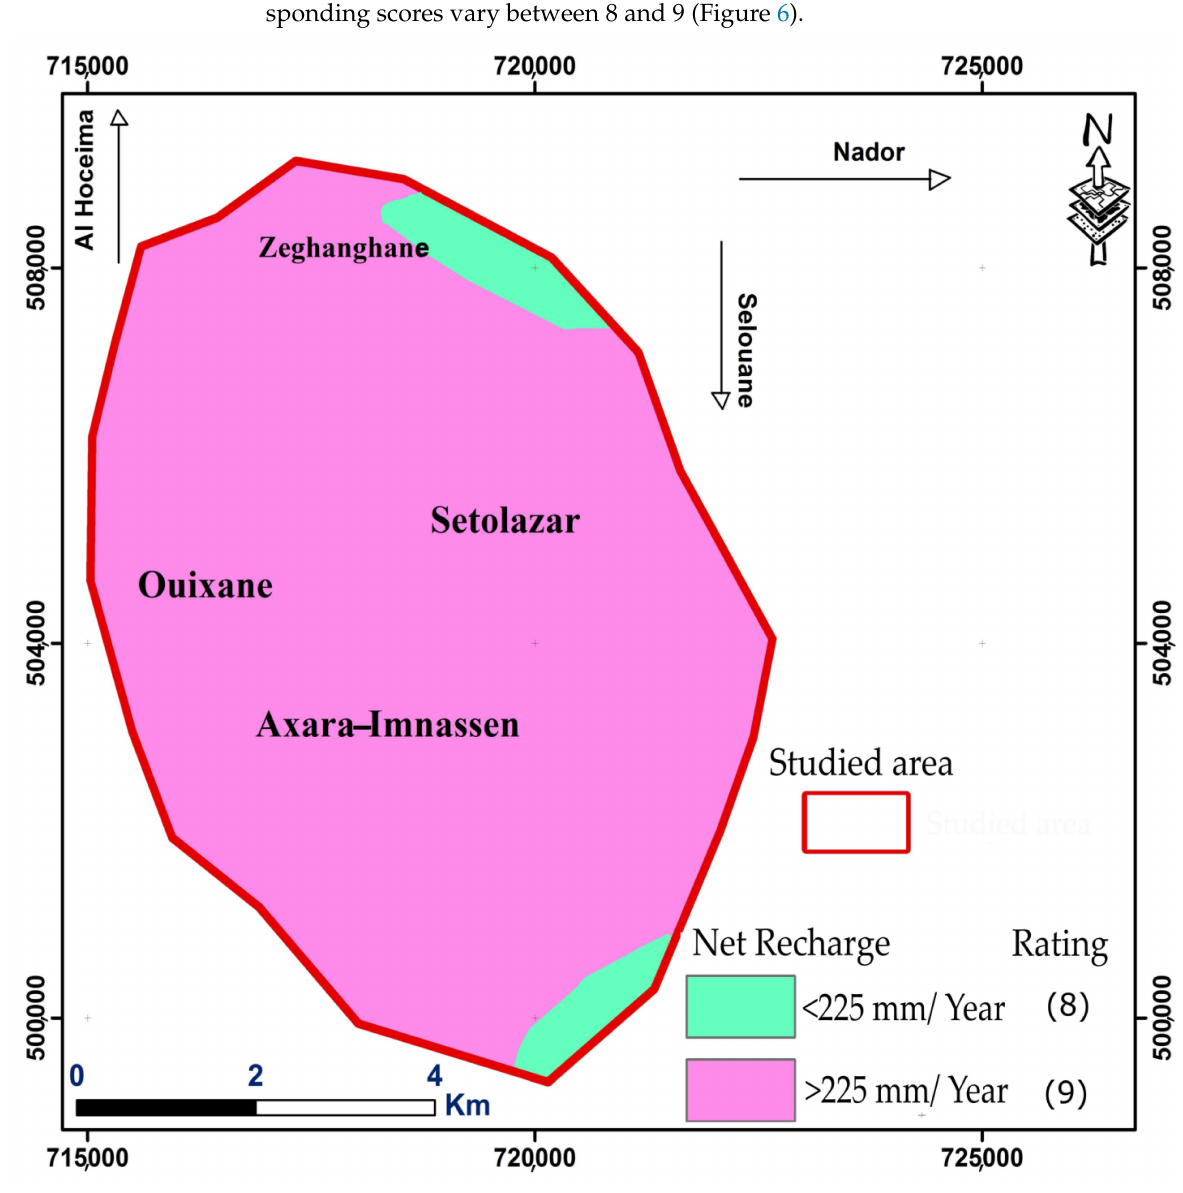
Figure 6. Net recharge map and attributed rating